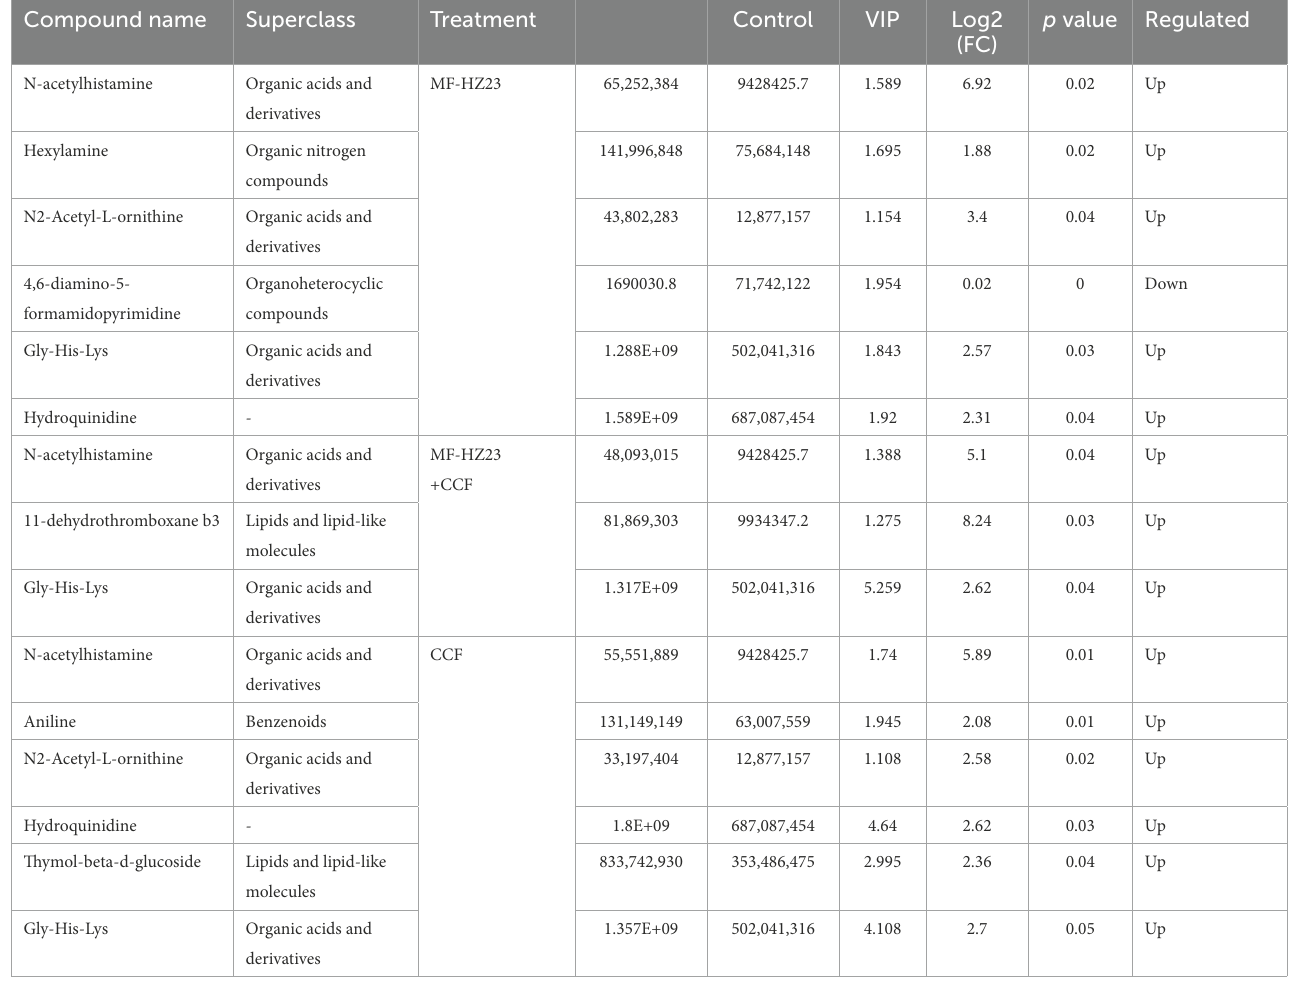
TABLE 5 List of differentially expressed metabolites (DEMs) by VIP, FC, and p